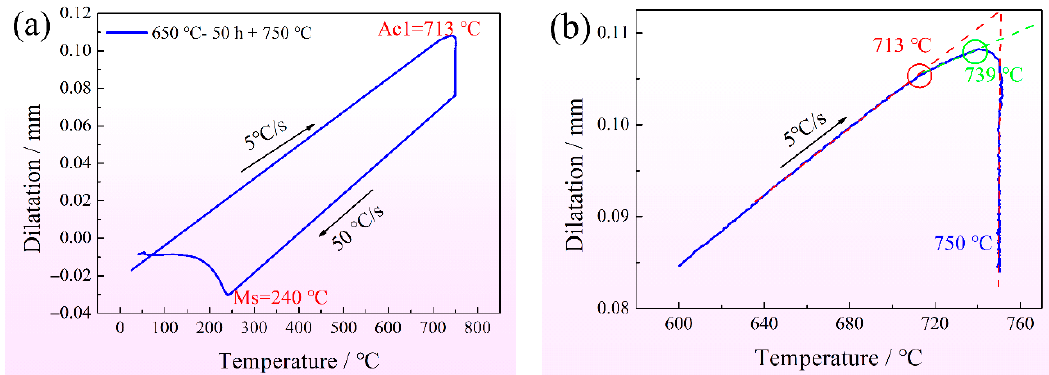
Figure 11. ( a ) Dilatometric curves after being intercritically annealed at 650 °C for 50 h; ( b ) magnified area near the phase transformation points.